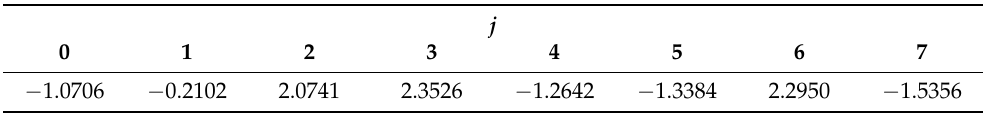
Table 3. The threshold of the output neuron and the synaptic weights from the hidden layer to the ( 2 ) output neuron ( w j